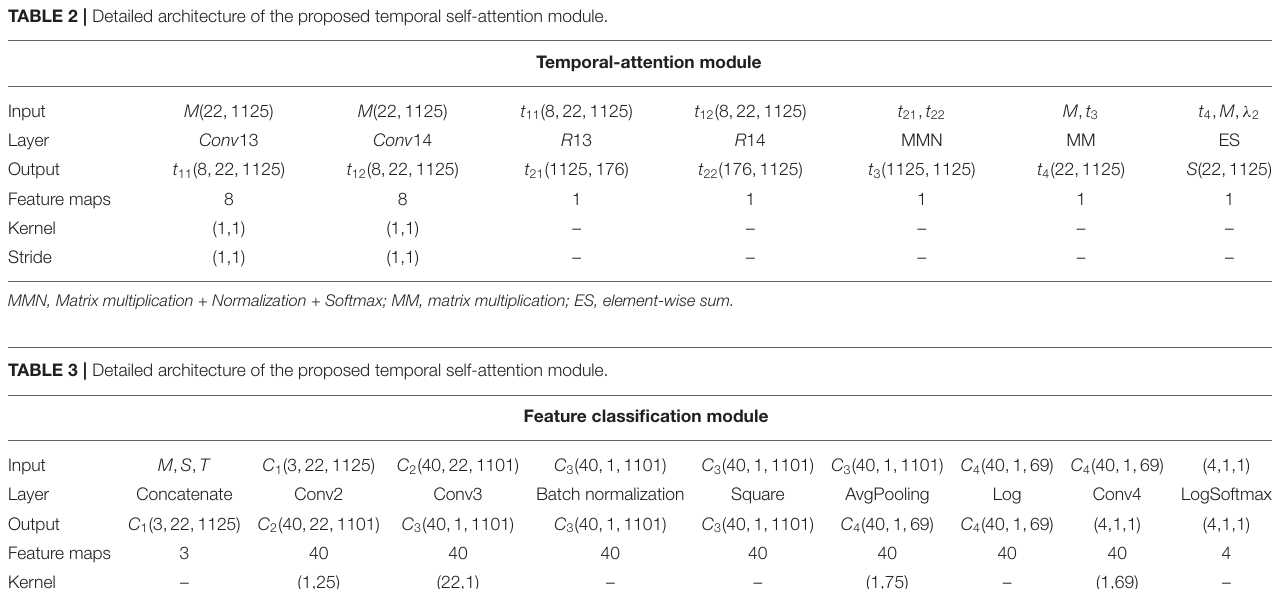
TABLE 2 | Detailed architecture of the proposed temporal self-attention module.